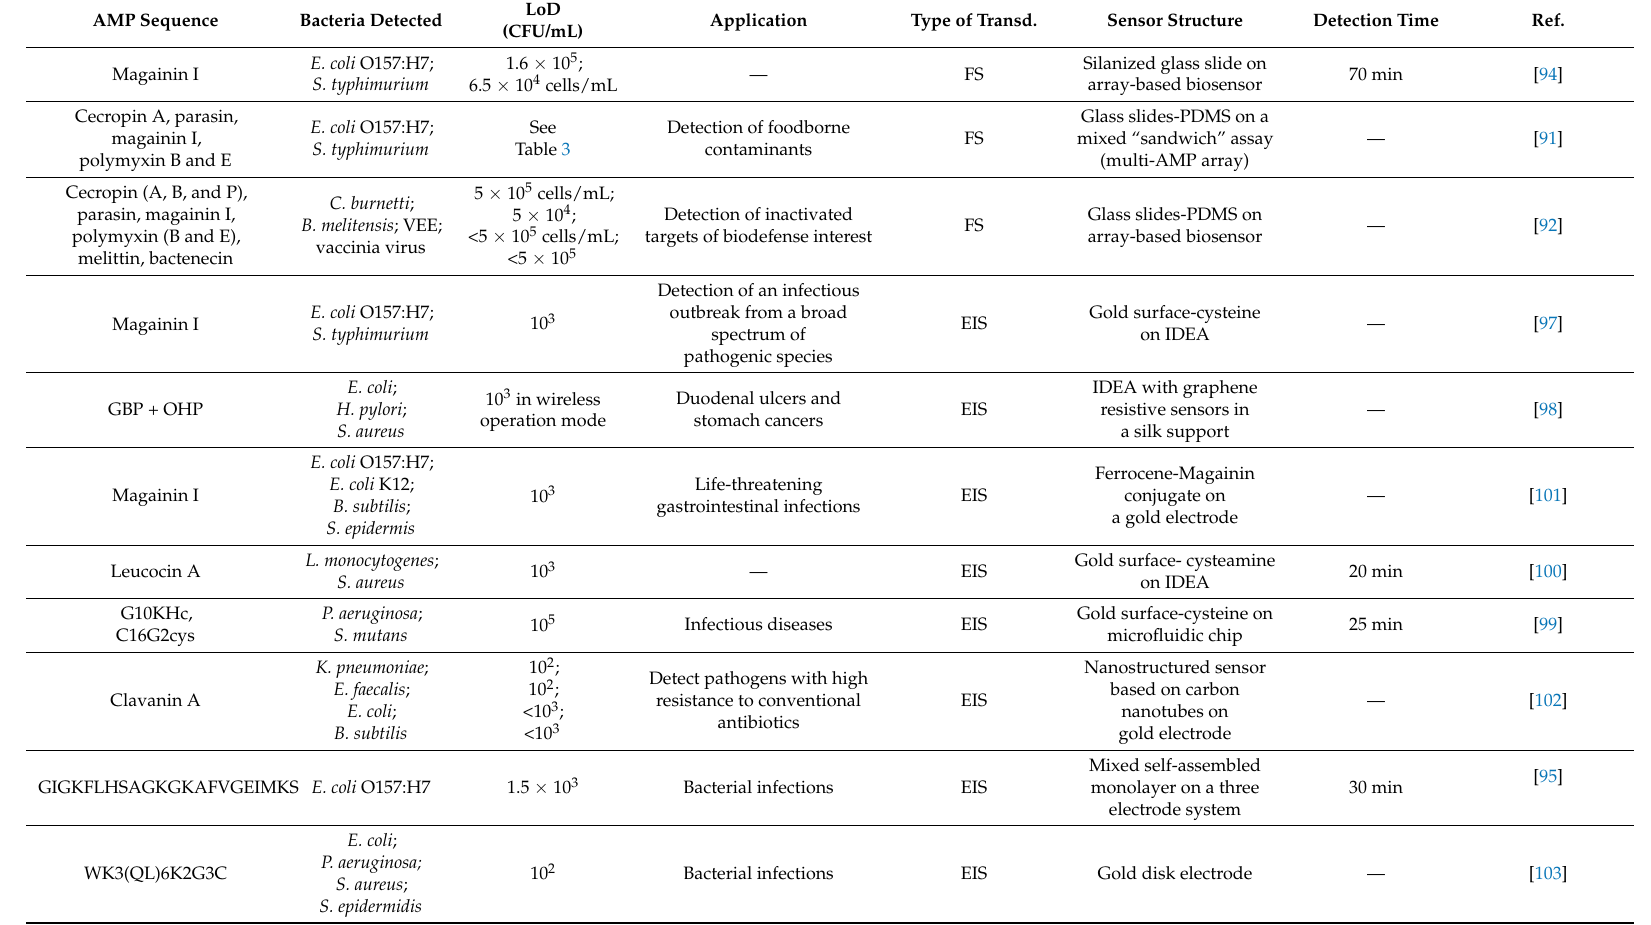
Table 2. AMP-based sensors for bacterial